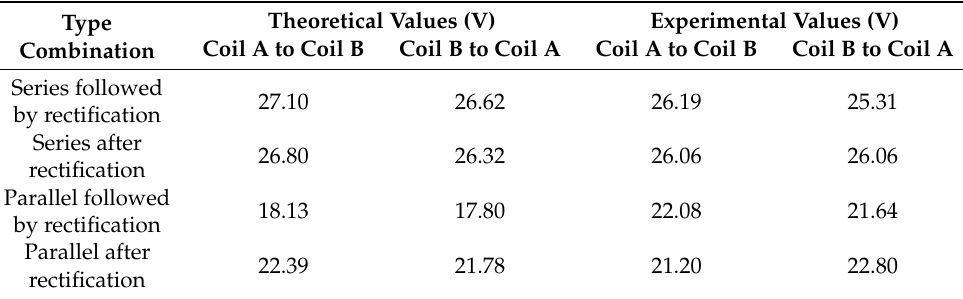
Table 2. The output maximum voltage is generated with different coil